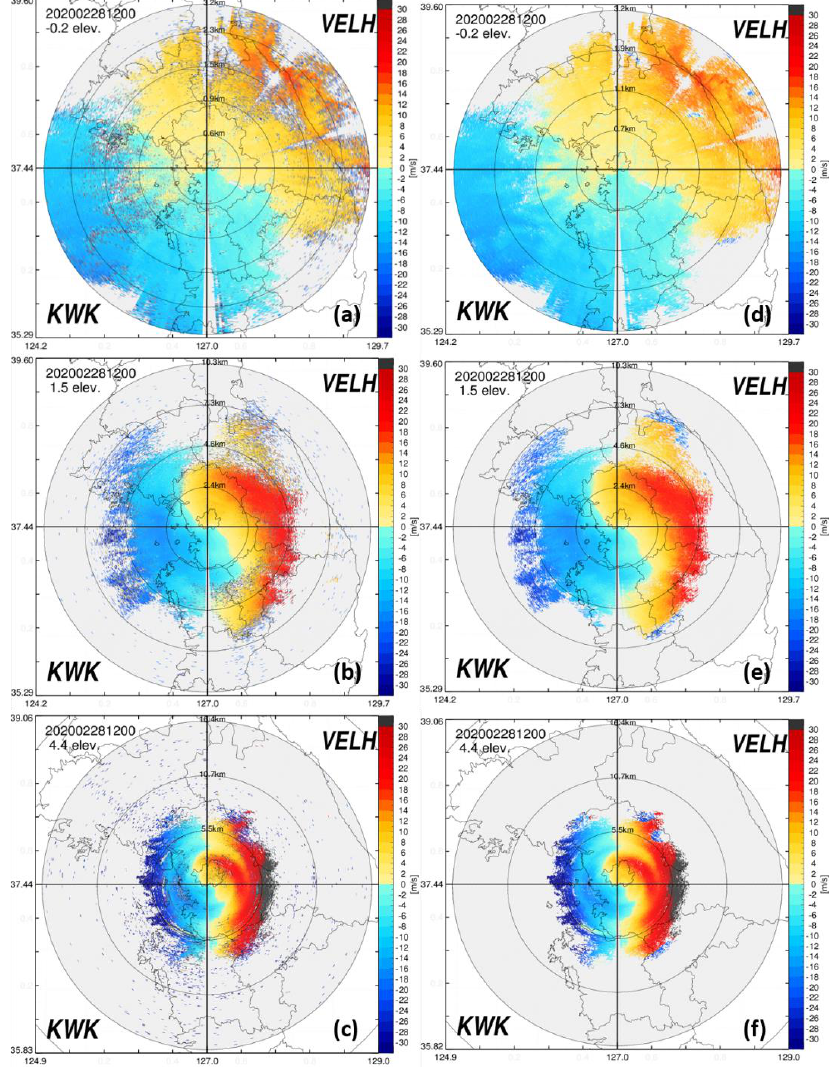
Figure 8. PPIs of radial velocity ( a – c ) before and ( d – f ) after quality control at elevation angles of −0.2°, 1.5°, and 4.4° for KWK at 1200 LST on 28 February 2020.